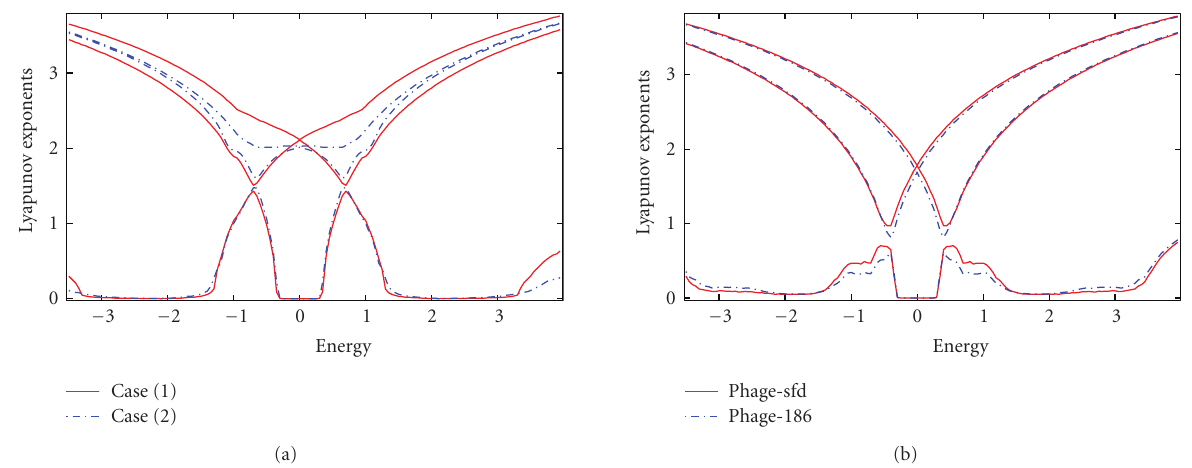
Figure 15: The Lyapunov exponents ( γ 1 , γ 2 , γ 3 ) as a function of energy in the three-chain model. (a) Modified Bernoulli model and (b) bacteriophages of E. coli (phage- fd , phage-186). The parameters are the same as the ones in Figure 14 except for on-site energies of C-chain ( Cn,n = 0 ).